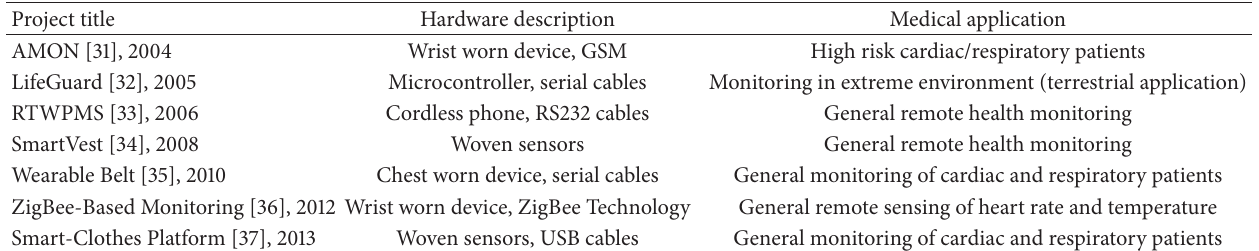
Table 1: Review on wearable systems for healthcare.